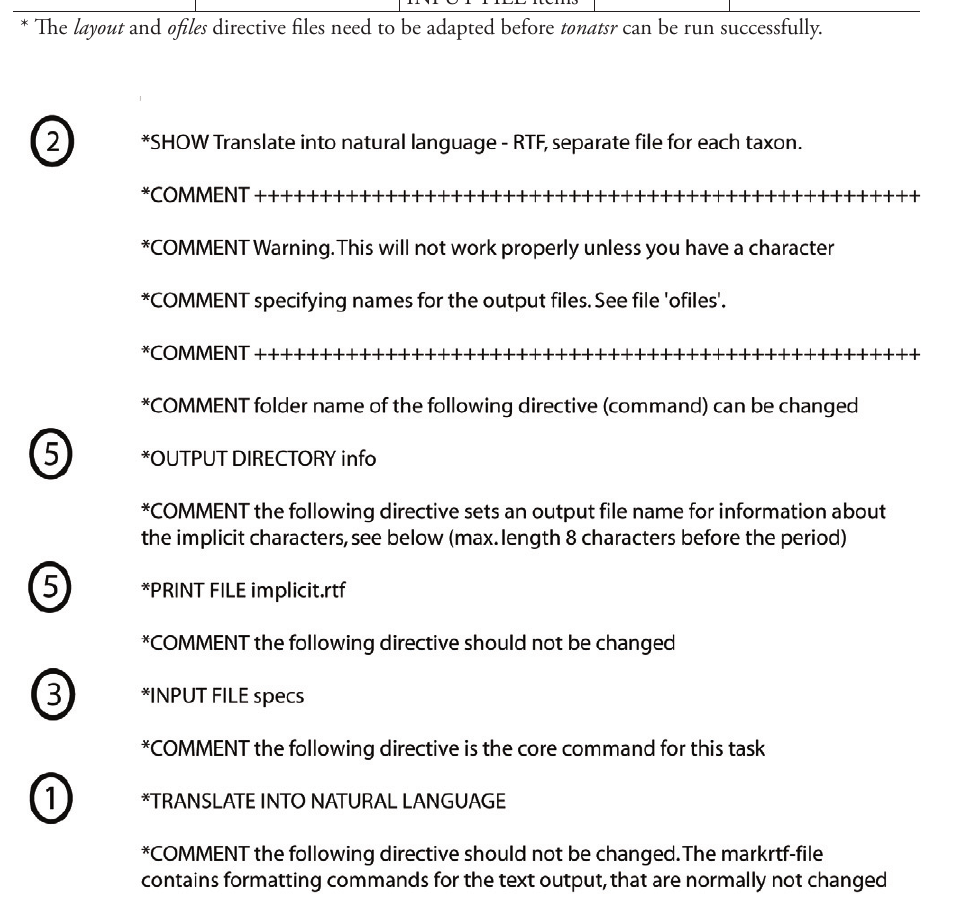
Figure 32. Th e tonatsr directive fi le contains the commands for producing natural language descrip- tions as separate fi les for each taxon. Th e numbers to the left of the directive fi le indicate diff erent classes of directives (see in Table 5). Th e grey oval shows commands where input of the user might be required. (continued on next